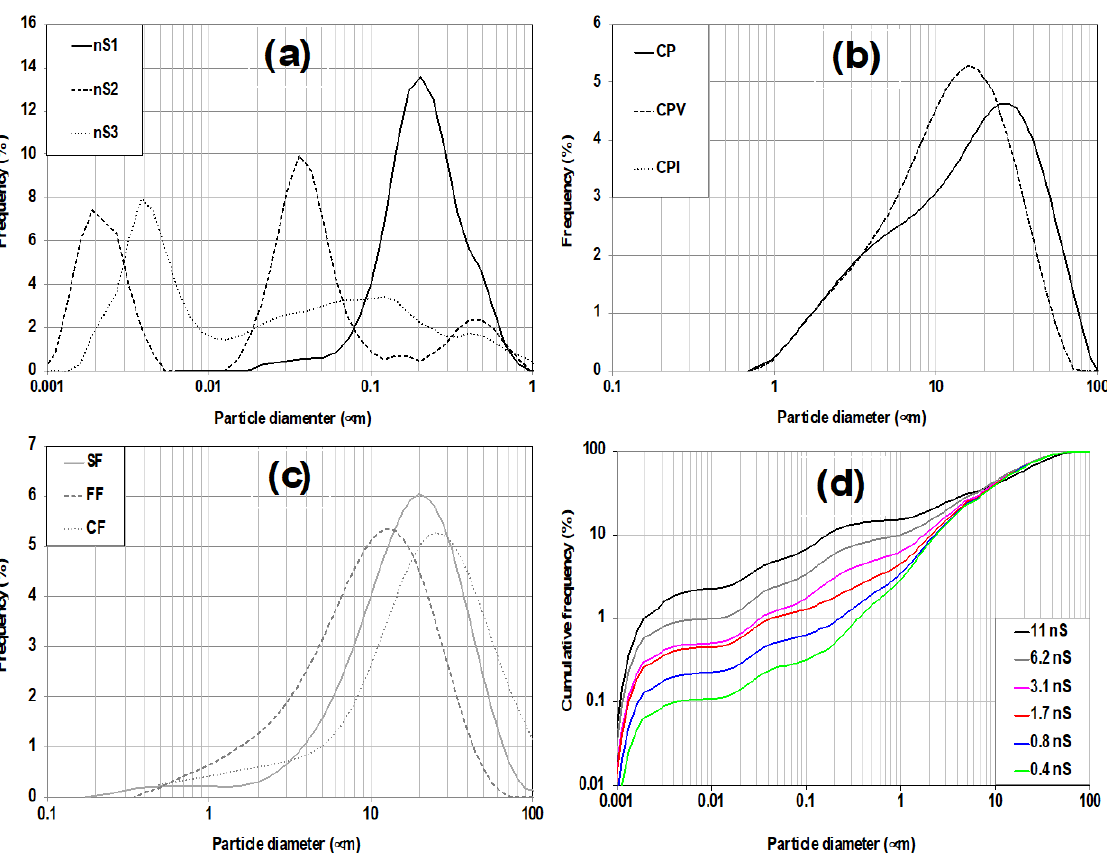
Figure 3. Particle size distribution (a) Nano-silicas (b) Cements and Clinker (c) Supplementary Cementitious materials (d) Mixtures